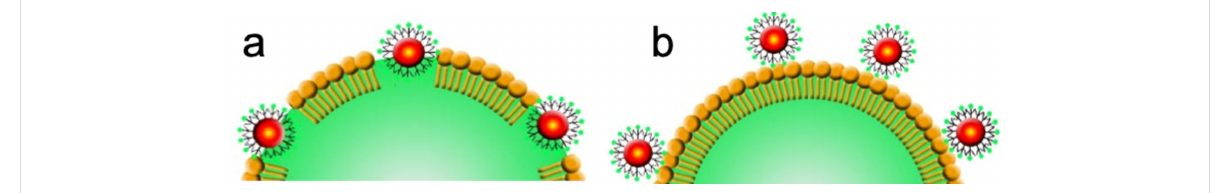
Figure 8: Schematic representation of dendronized IONPs a) incorporated within the MB DPPC shell and b) located at the surface of this shell.